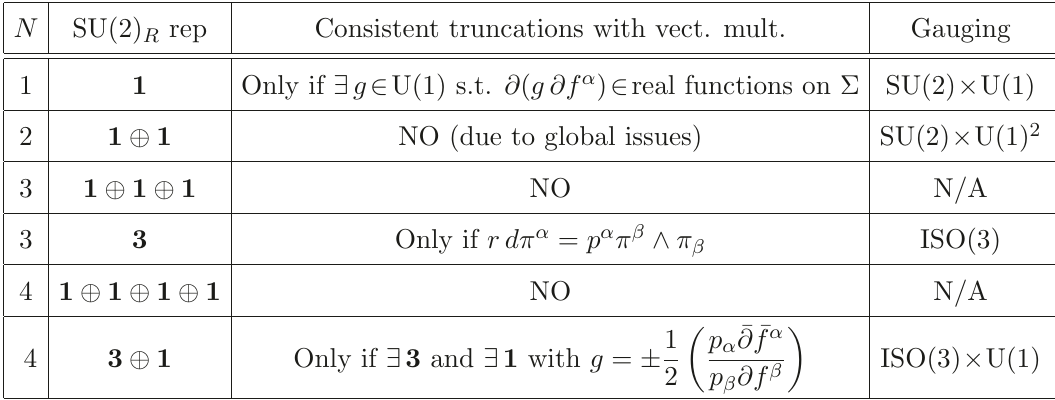
Table 1 . Possible consistent truncations with N vector multiplets around supersymmetric AdS 6 S 2 vacua in IIB and the resulting gauging of the gauged SUGRA. Consistency requires that N 4 and that the vector multiplets form representations of SU(2) R , the R -symmetry of the AdS 6 vacua. The one-forms π α are explicitly defined in terms of the background functions f α , see equations (10.63) and